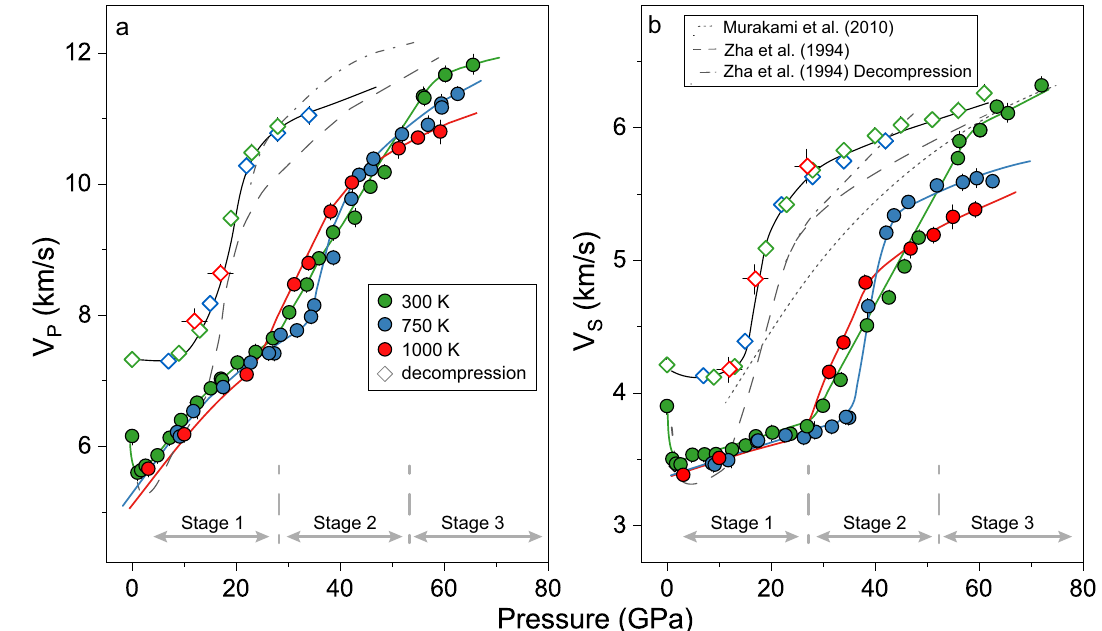
Figure 2. V P and V S of SiO 2 glass at given temperatures. ( a ) V P of SiO 2 glass; ( b ) V S of SiO 2 glass. Green, blue, and red circles represent the velocity data at 300 K, 750 K and 1000 K by compression, respectively. Green, blue, and red diamonds are our results in decompression for SiO 2 -glass quenched from 300 K, 750 K, and 1000 K, respectively. All the colour solid lines are shown for readers to follow the trend with pressure. Grey dotted lines: SiO 2 glass in Murakami et al. (2010) 28 ; grey long-dashed lines: SiO 2 -glass in compression in Zha et al. (1994) 49 ; grey dotted and dashed lines: SiO 2 -glass in decompression in Zha et al. (1994) 49